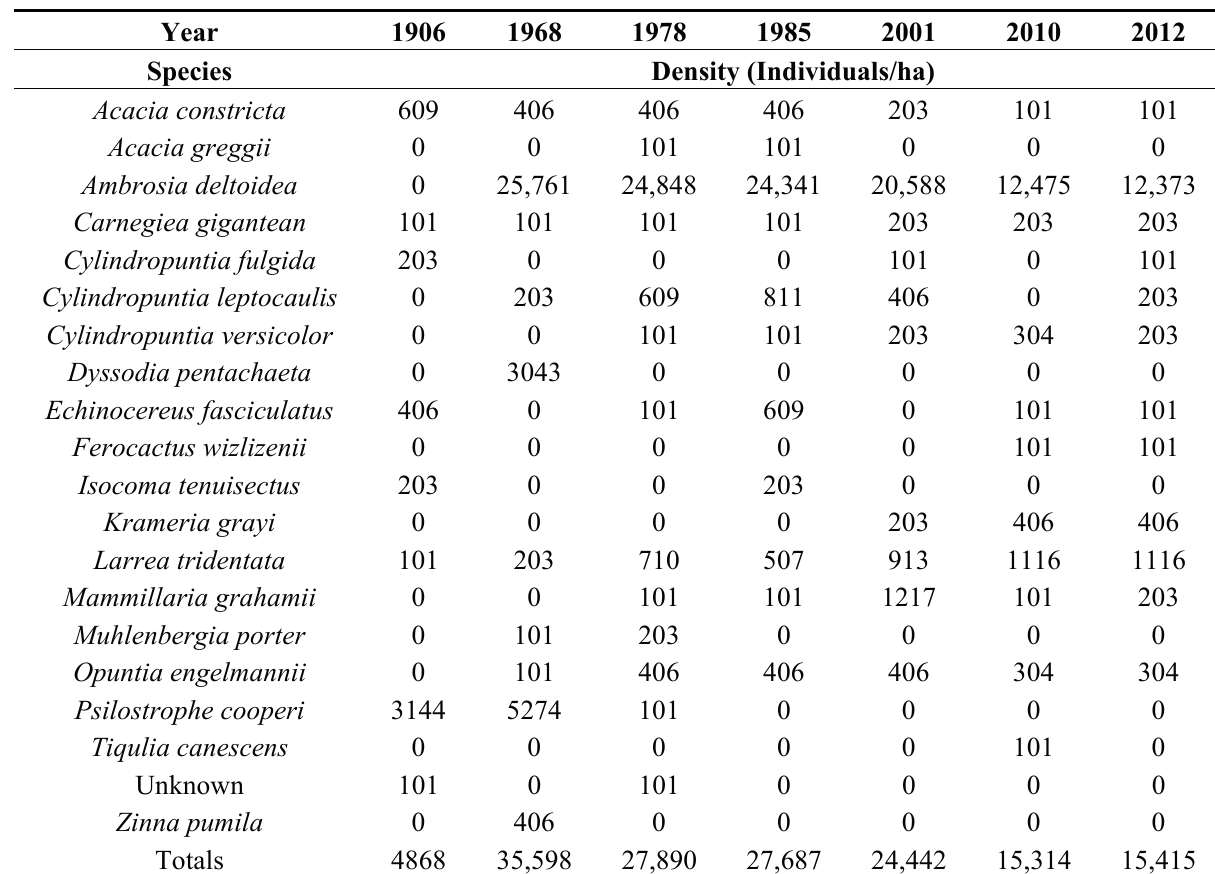
Table 2. History of measurements of density of perennial vegetation on plot 4 at the Desert Laboratory in Tucson,